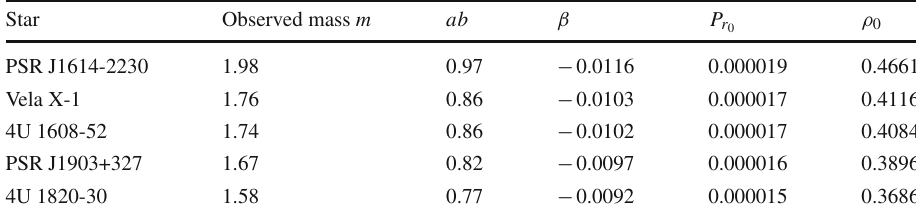
Table 1 Mass ( m ) , central